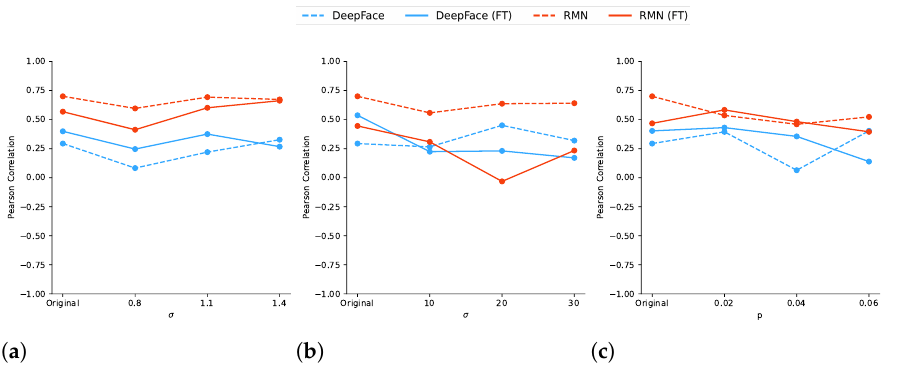
Figure 4. Illustration of the Pearson’s correlation coefficients calculated between humans’ and (original and fine-tuned) models’ errors for each distortion type (i.e., GB, GN, and SP) and level. ( a ) Gaussian blur; ( b ) Gaussian noise; ( c ) salt-and-pepper. It is interesting to notice that, in general, the fine-tuned version of DeepFace obtained higher correlation coefficients than its original version, while the contrary happened for RMN (i.e., errors made by the original version of RMN were closer to humans’ errors than errors made by its fine-tuned version). As an example, Figure 5 shows the confusion matrices generated for images distorted using Gaussian blur when removing the main diagonal elements. In this case, we can observe that RMN tended to have prediction errors between the same pairs of emotions for humans, while DeepFace presented more spread errors. This can be explained by the fact that they pay attention to different features in an image to perform their classification.